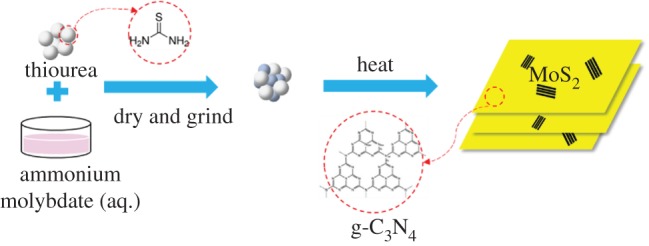
Schematic illustration of the synthesis of g-C3N4/MoS2 hybrid catalysts.